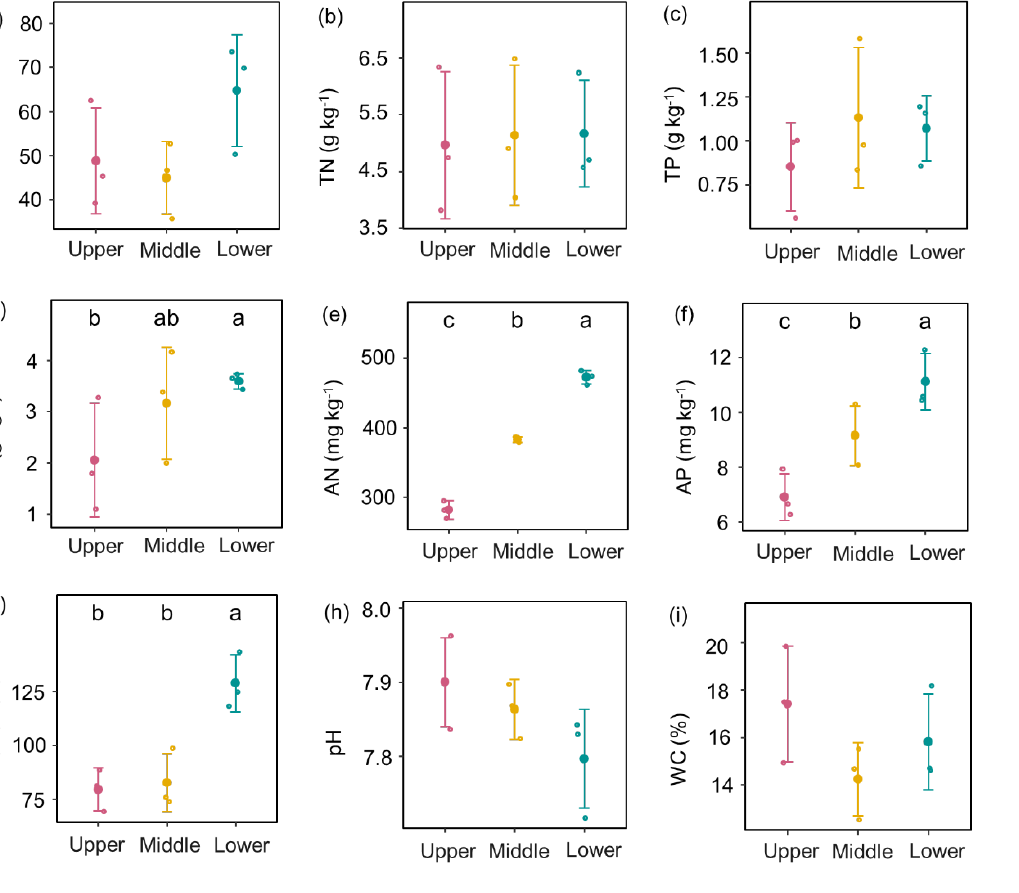
Figure 1. Differences in soil physiochemical properties among upper, middle, and lower slope positions. ( a ) Soil organic matter; ( b ) Total nitrogen; ( c ) Total phosphorus; ( d ) Total potassium; ( e ) Alkali hydrolyzable nitrogen; ( f ) Available phosphorus; ( g ) Available potassium; ( h ) soil pH; ( i ) water content. Values are means ± standard errors ( n = 3). Different letters indicate statistical differences at p < 0.05 among upper, middle, and lower slope